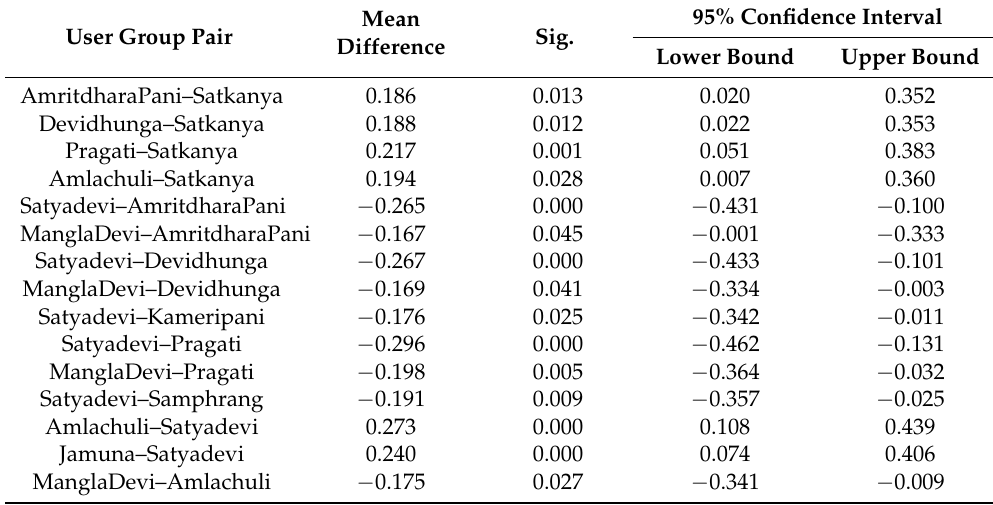
Table 5. Results of a Tukey HSD post-hoc comparison.